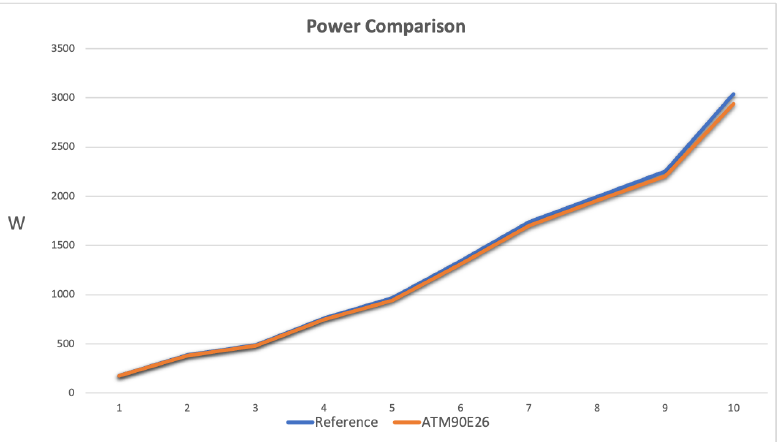
Figure 15. Comparison of power measurements: Measurements are on the vertical axis in Watts, whereas the horizontal axis expresses the number of measures